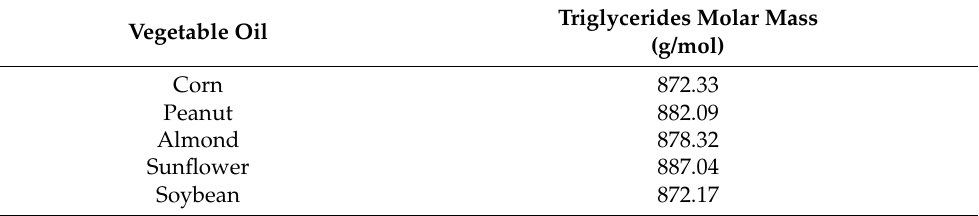
Table 3. Calculated mean weighted molar masses of vegetable oils included in this study. Vegetable Oil